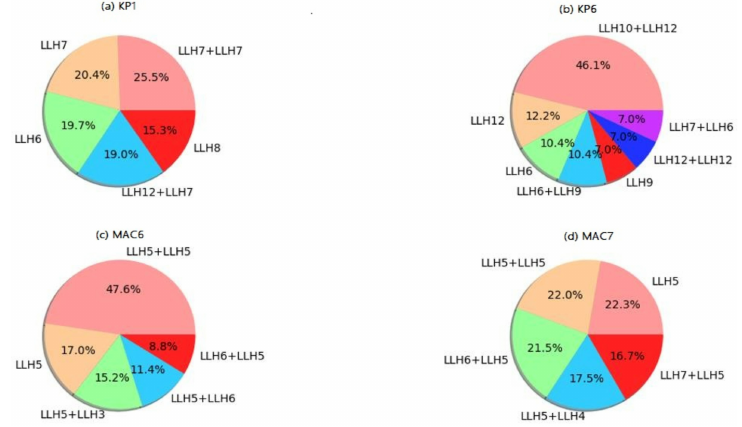
Figure 8. Analysis of two KP and two MAC